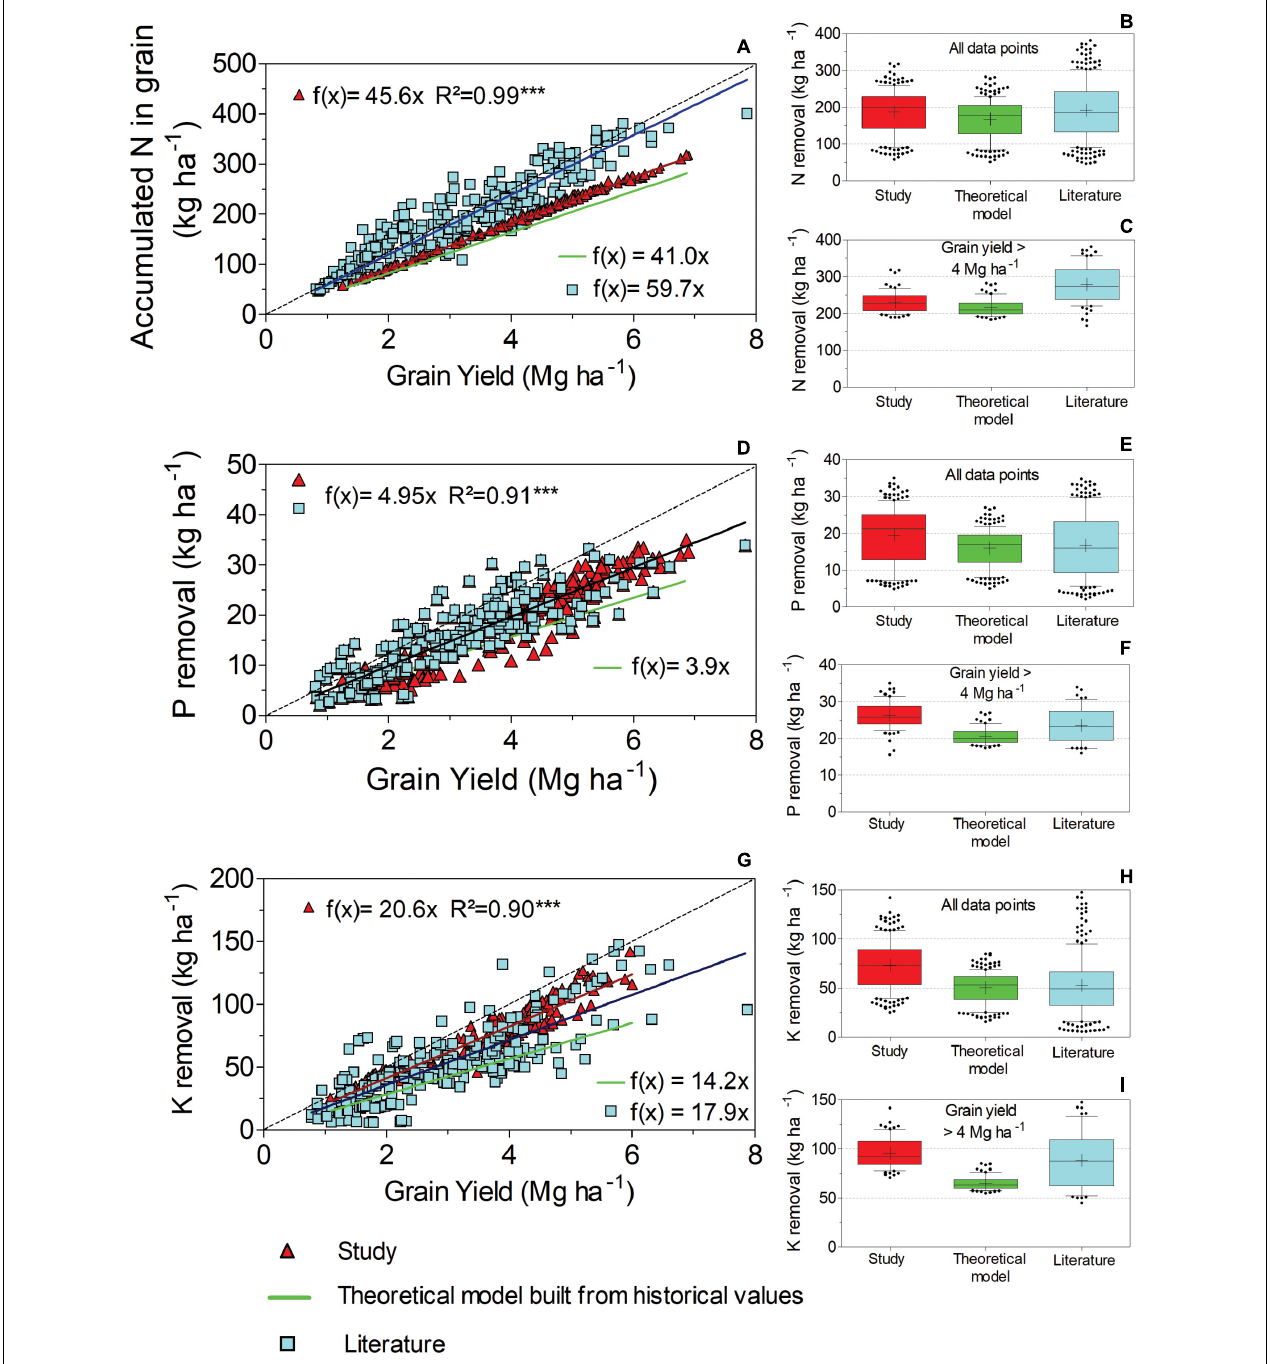
FIGURE 4 | Linear functions to describe N, P, and K removal relative to grain yield (A, D, G , respectively). Differences among the datasets were tested through an F test ( p < 0.05). When no differences were found between the study and literature, a single model was pooled (indicated with a black line). Box plots (B, E, H) display the data distribution of the overall yield for N, P, and K removal by harvest. Box plots (C, F, I) display the distribution of yield data above 4 Mg ha − 1 for N, P, and K removal by harvest. ***Significant at <